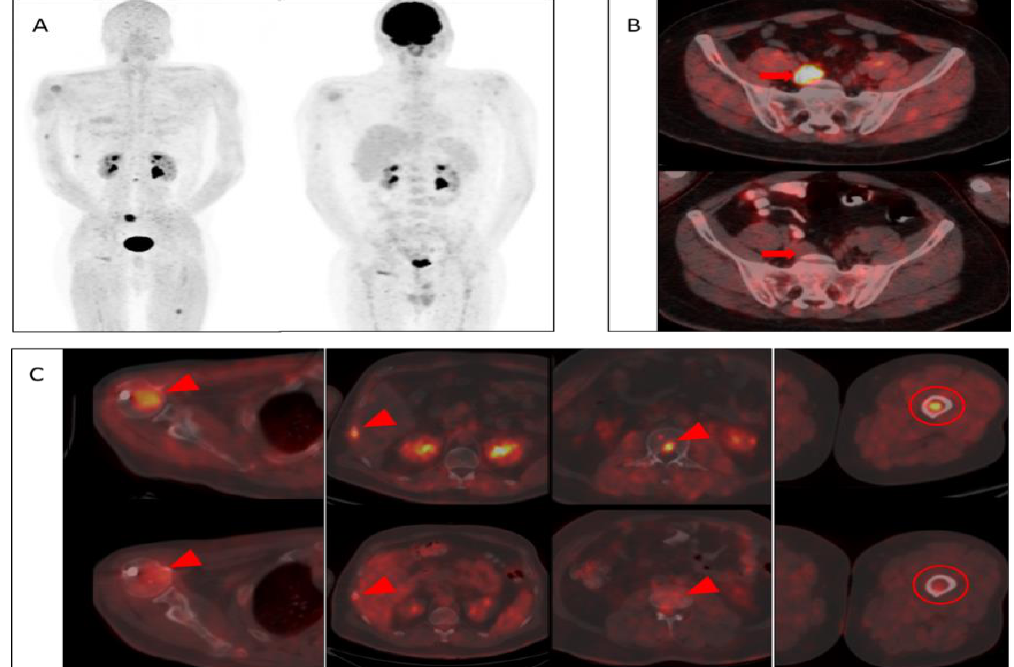
Figure 2. Patient No 3. 39-year-old male diagnosed with MM. ( A ) Visual comparison of maximum intensity projections of both modalities showed superior image quality and higher specific activity retentions in [68Ga]FAPI PET/CT (Left) without non-specific diffuse medullary uptake as in [18F]FDG PET/CT (Right). ( B ) In axial plane evaluations, both imaging methods demonstrated extramedullary involvement of MM in the presacral lymph node (Arrows); however, SUV max value of the lymph node were noted to be significantly higher in [68Ga]FAPI PET/CT (Upper row). ( C ) In the visual evaluation of the bone lesions (Arrow heads), [68Ga]FAPI PET/CT (Upper row) demonstrated higher activity retentions in all locations with significantly lower background activity compared to [18F]FDG PET/CT (Lower row). Also, more pronounced focal activity retention was observed in the intramedullary region of the left femur with [68Ga]FAPI PET/CT (Upper row) compared to [18F]FDG PET/CT (Lower row), without morphological pathology (Circles). 4. Discussion Imaging modalities in MM play an important role in diagnosis, determining disease dissemination, and evaluation of response to treatment. On whole-body x-radiography (WBXR), multiple myeloma lesions typically have a perforated osteolytic appearance. However, for it to be detected as a lytic lesion on radiography, at least 50% of the relevant trabecular bone must be destroyed. On the other hand, computed tomography (CT) has been found to be more sensitive than WBXR in detecting lytic lesions with less than 5% trabecular bone destruction [5,20,21]. Both WBXR and CT assess the damage of tumor cells to mineralized bone tissue, but do not provide information on tumor cell viability or activity. On the other hand, magnetic resonance imaging (MRI) and PET/CT are more functional imaging methods, as they can evaluate the diffusion of interstitial water molecules and glucose uptake, which are markers of viability in tumor tissue [22].The International Myeloma Working Group has recommended that use of [18F]FDG PET/CT in MM could provide beneficial information about the metabolism of plasma cells. The most important advantage of [18F]FDG PET/CT is its ability to assess disease burden with highaccuracy and to distinguish metabolic activity among various lesions [23,26]. However, utilization of [18F]FDG PET/CT in patients with MM has some limitations. Studies have shown that false positive results can be detected with [18F]FDG PET/CT in certain situations, such as low [18F]FDG affinity, recent steroid treatment, hyperglycemia, non-specific bone marrow involvements, and small lytic lesions in the